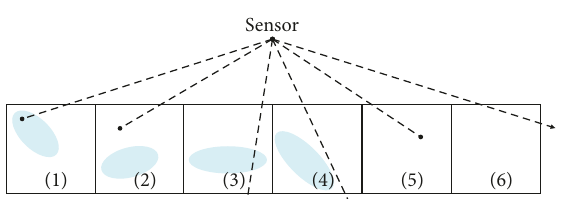
Figure 6: Geometric relationship between a measured point and a voxel.